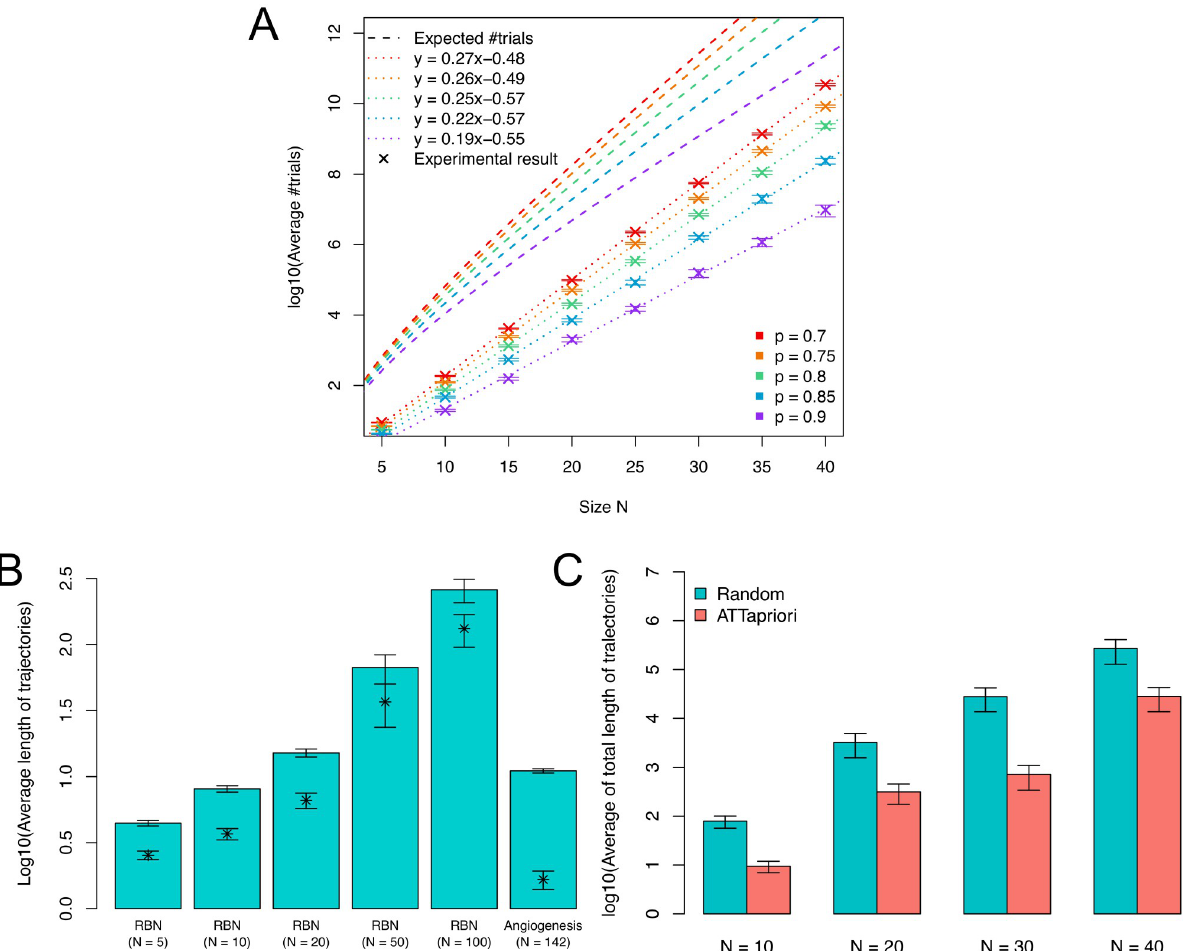
Fig 2. Analysis of synthetic random networks and the angiogenesis network. (A) The number of expected trials in synthetic random networks. The average number of trials and the expected number of trials for attractor detection of synthetic random N - K networks with the prior probability from 0.7 to 0.9. The horizontal axis shows the size of input random N - K networks, where K is fixed at 2. The dotted lines indicate the regression lines for the experimental results. (B) The lengths of trajectories of synthetic random networks (RBNs) and the angiogenesis network. The average lengths of trajectories of 100 trials from random initial states to attractors for random N - K networks ( N = 5, 10, 20, 50, 100 and K = 2) and the angiogenesis network ( N = 142). The symbol ‘ � ’ and the bars indicate the averages of period lengths and the standard errors, respectively. (C) The total lengths of trajectories required to reach the target attractors. The ATTapriori and Random are the cases with and without a priori information, respectively. The result shows that the average total lengths of trajectories of 100 experiments not including period lengths until reaching the target attractors for the BN sizes of N = 10, 20, 30, and 40, where the prior probability in ATTapriori was set to